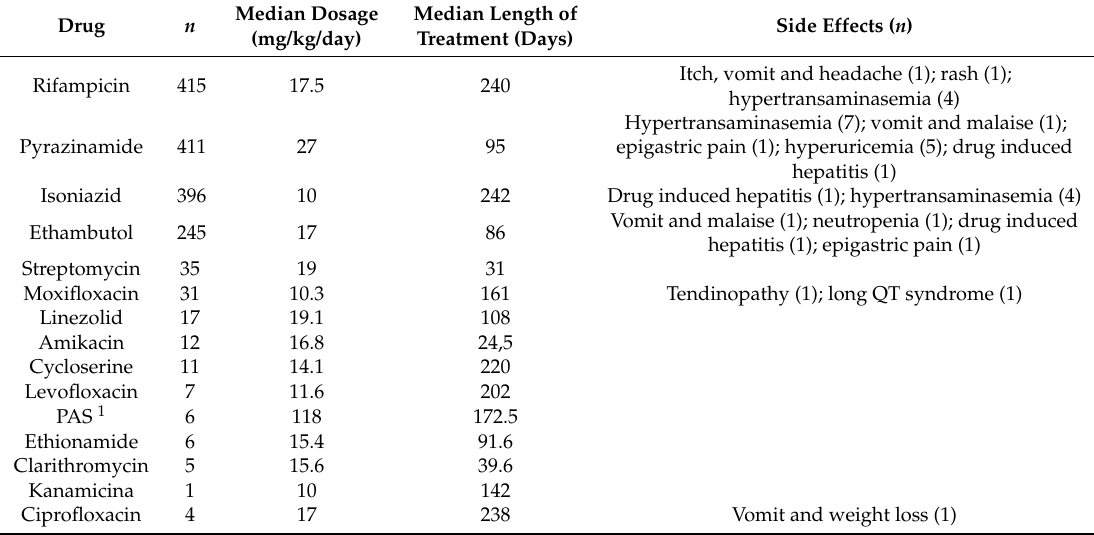
Table 5. Active TB